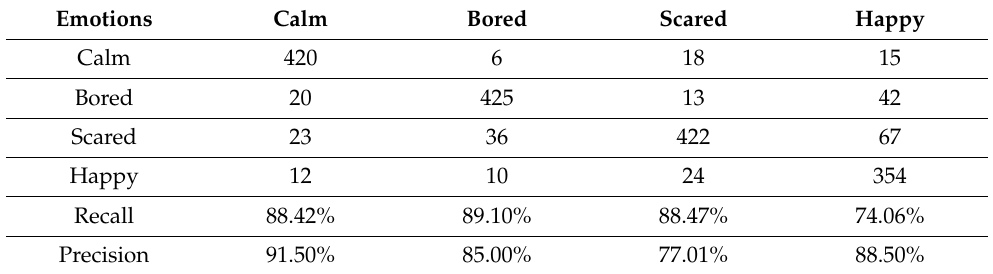
Table 10. Confusion matrix for this study (RBFK1).